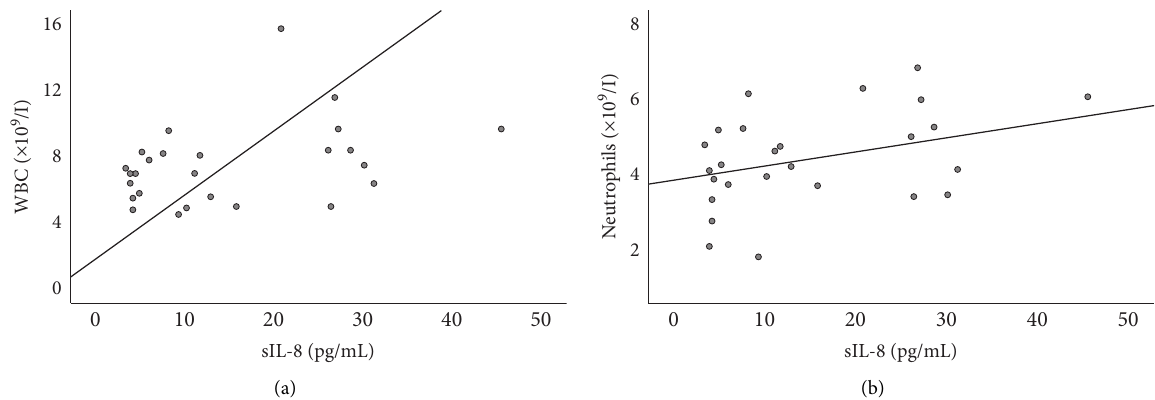
Figure 3: Correlations between IL-8 serum levels and peripheral blood leukocyte (a) and neutrophil (b) counts, in patients with CTCL. In this figure, 1 outlier was excluded for correlations involving sIL-8 (sIL-8 > 200pg/mL, corresponding to a patient with hyperleukocytosis). Statistical analysis was performed using Kendall’s tau-B correlation coefficient. Statistics (including/excluding the outliers): sIL-8 vs. leukocyte count: p � 0 . 030; R =0.300/ p � 0 . 085; R =0.243; sIL-8 vs . neutrophil count: p � 0 . 021; R = 0.317/ p � 0 . 061; R =0.262. CTCL, cutaneous T-cell lymphoma; IL, interleukin; sIL-8, interleukin-8 serum levels; and WBC, white blood